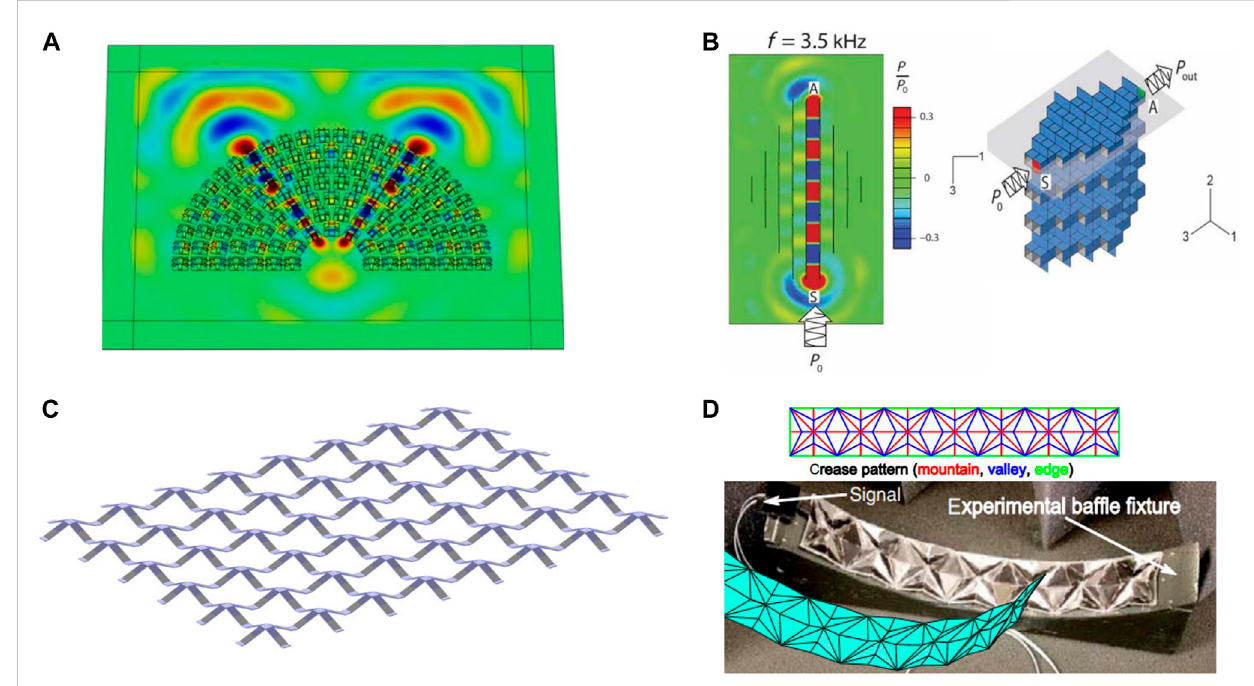
FIGURE 3 Examples of origami and kirigami. (A) Design of kirigami elastic hyperlens for fl exural wave fi eld (Zhu et al., 2018). (B) Propagation of sound waves in origami-inspired waveguides (Babaee et al., 2016). (C) Piezocomposite kirigami auxetic lattice for adaptive elastic wave fi ltering (Ouisse et al., 2016). (D) Crease pattern of foldable tessellations for ef fi cient guiding of acoustic waves (Zou et al.,